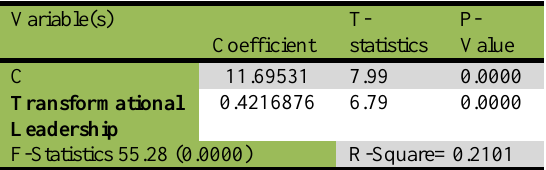
Table 3: Summary of Hypothesis 1 Result (Dependent